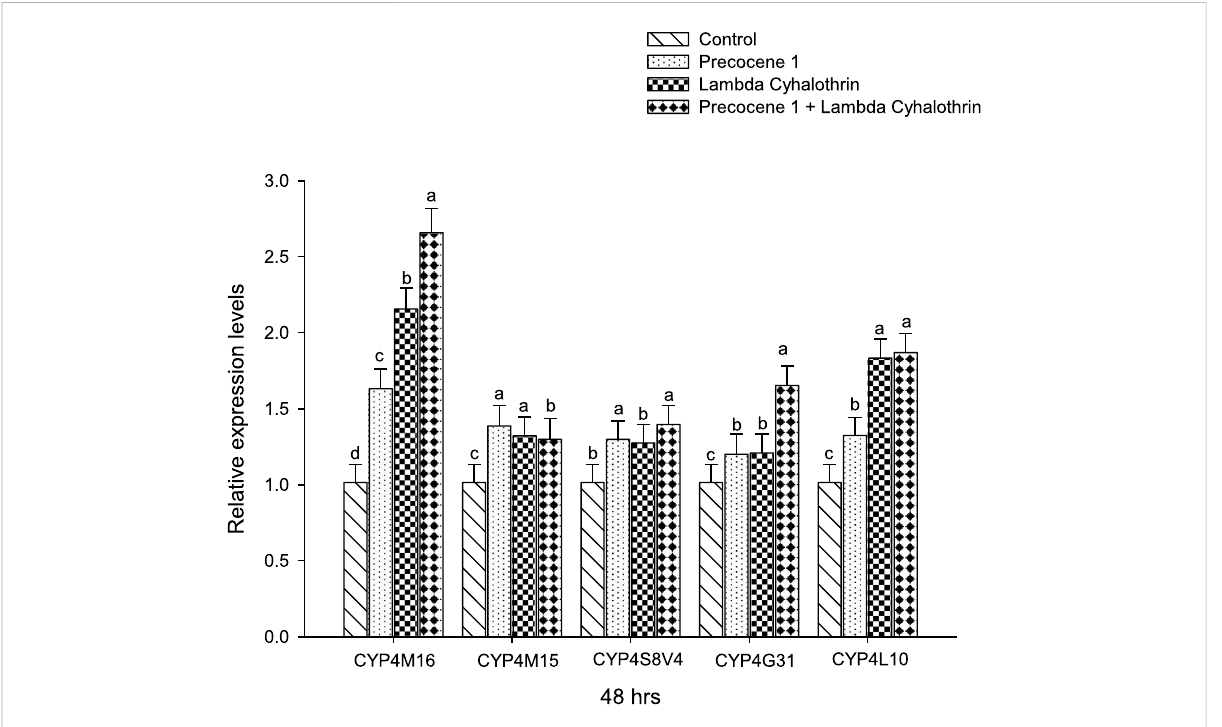
FIGURE 6 Effect of Precocene 1 on Spodoptera litura larvae tolerance to λ -cyhalothrin and relative expression levels of cytochrome P450s genes after 48 h. The transcription levels of three cytochrome P450s genes are determined by quantitative real-time PCR, normalized to different genes. Each bar indicates the mean of transcription levels (±SE), each being replicated. Different letters above bars indicate signi fi cant differences ( p < 0.05) according to the Tukey HSD